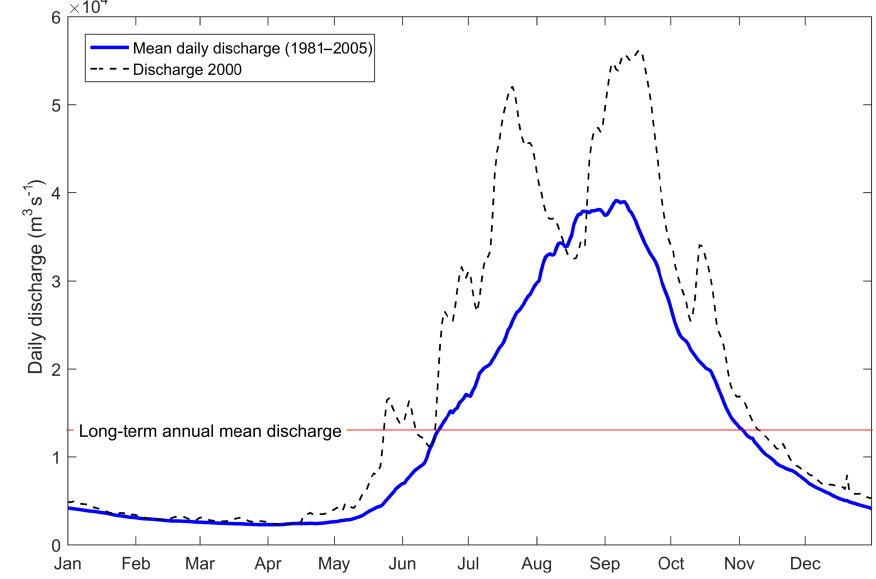
Figure 3. Temporal distribution of daily water discharge at Kratie (available data from Darby et al., 2016).